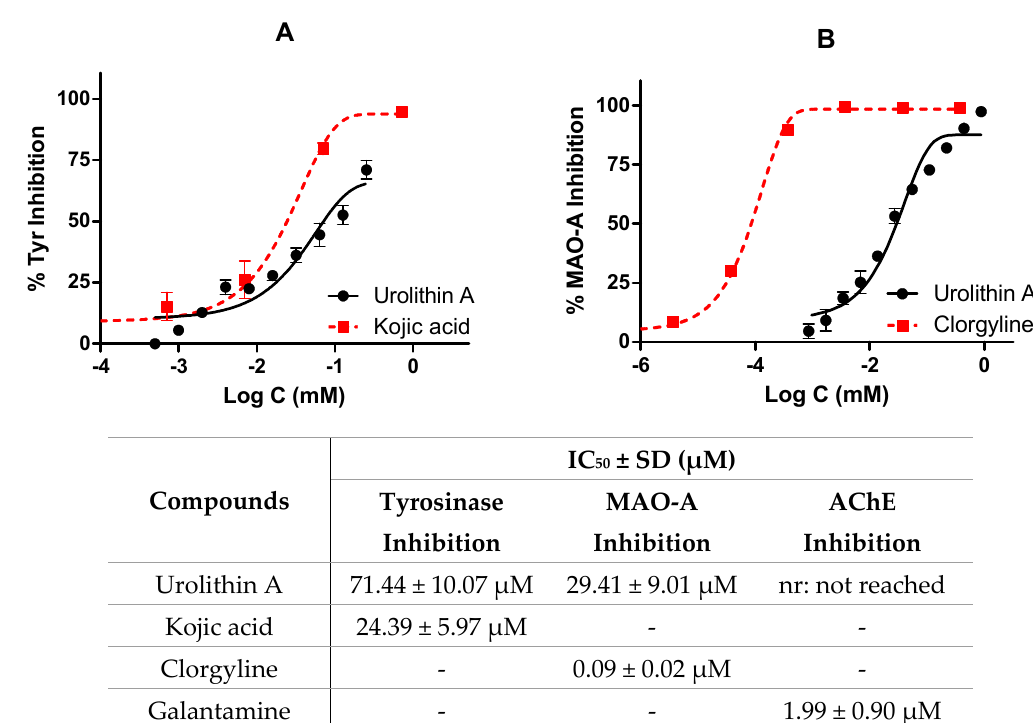
Figure 7. Enzymatic inhibition of urolithin A. IC 50 values were calculated by non-linear regression. ( A ) Tyrosinase inhibition profiles of urolithin A and kojic acid. ( B ) Monoamine oxidase A (MAO-A) inhibition profiles of urolithin A and clorgyline.